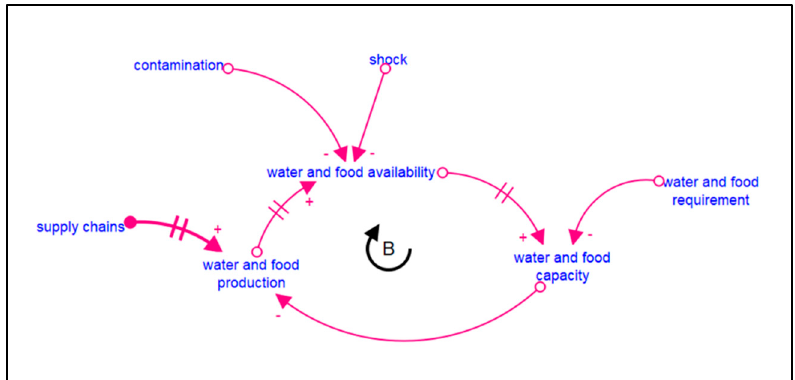
Figure 3. Causal loop diagram of food and water.